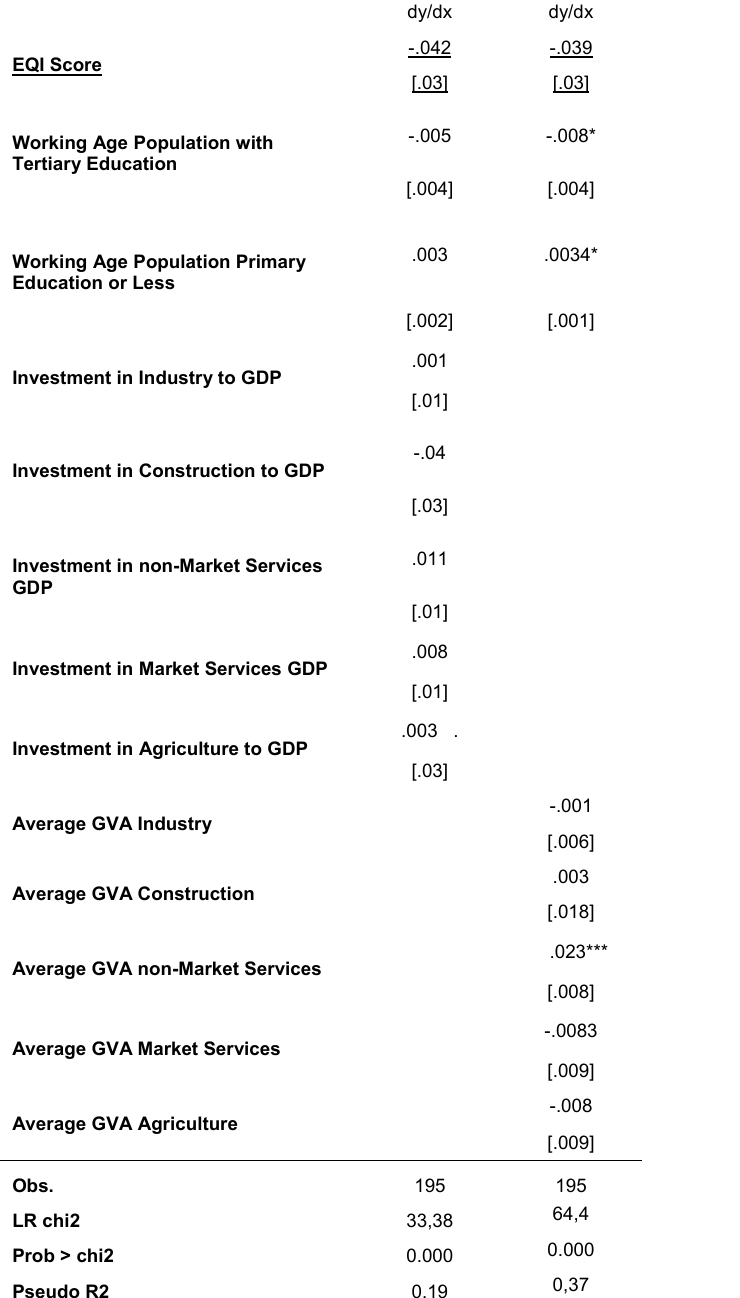
Table 7. Marginal effects on probability Y=1|X. Group B – robustness